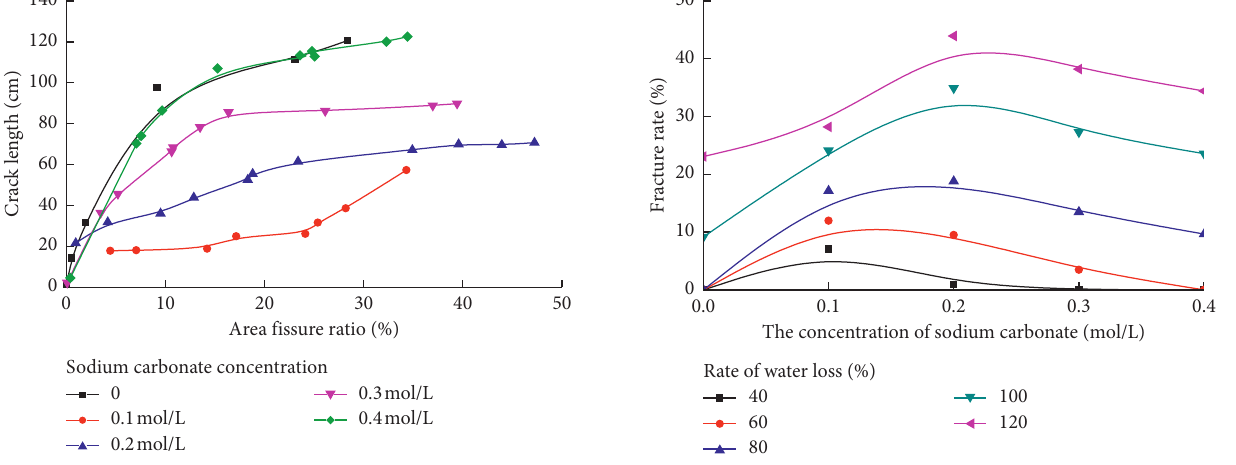
Figure 9: Relationship between the sodium carbonate concen- tration and the crack ratio.